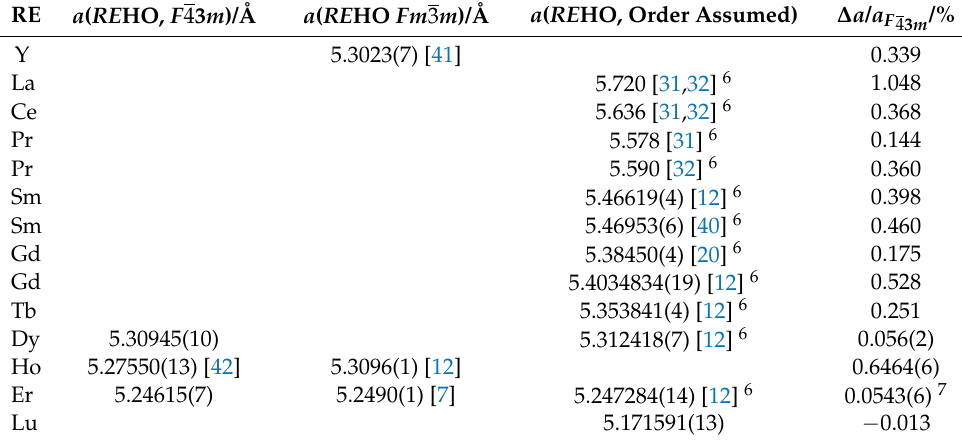
Table 6. Lattice parameters of cubic hydride oxides and their relative deviations from the values of anion ordered phases with space group F 43 m . In cases where the anion-ordered compound is not known, extrapolated values were employed (see Figure